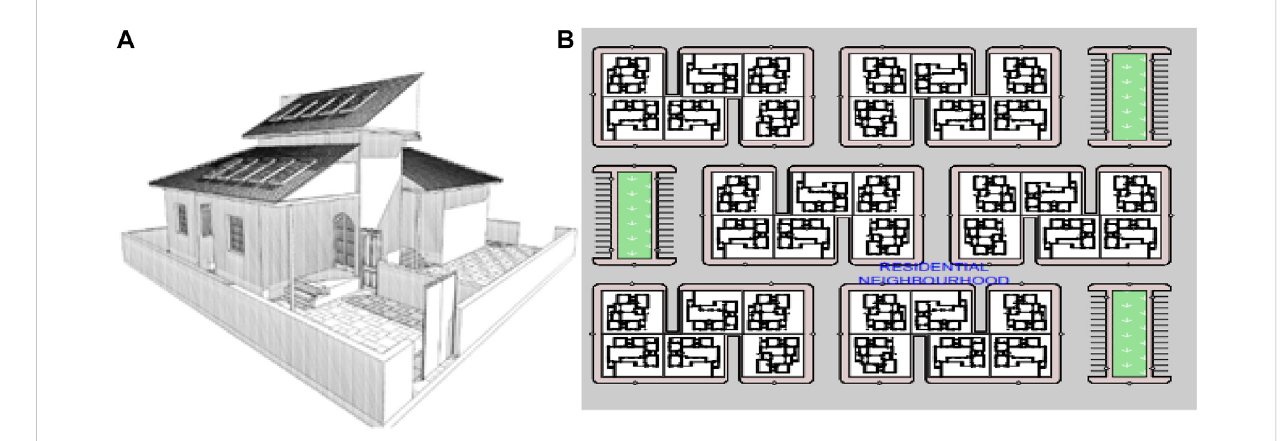
FIGURE 4 ViewofadesignedresidentialhousetypedesignedintheAzhariCityBlock10area. (A) Perspectiveofahouse. (B) UrbanplanninglayoutofBlock10.